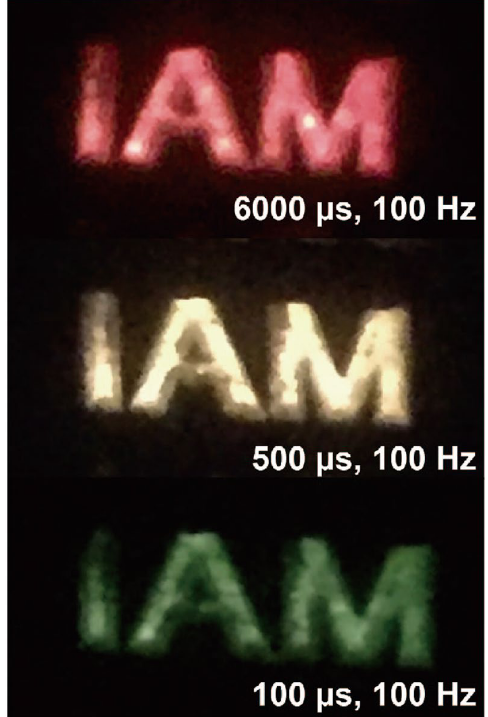
Figure 4. The photograph of tunable emission color of NaYF 4 :Er/Tm@NaYF 4 nanoparticles under pulsed laser excitation for anti-counterfeiting. The size of one character is 3 mm × 3 mm.